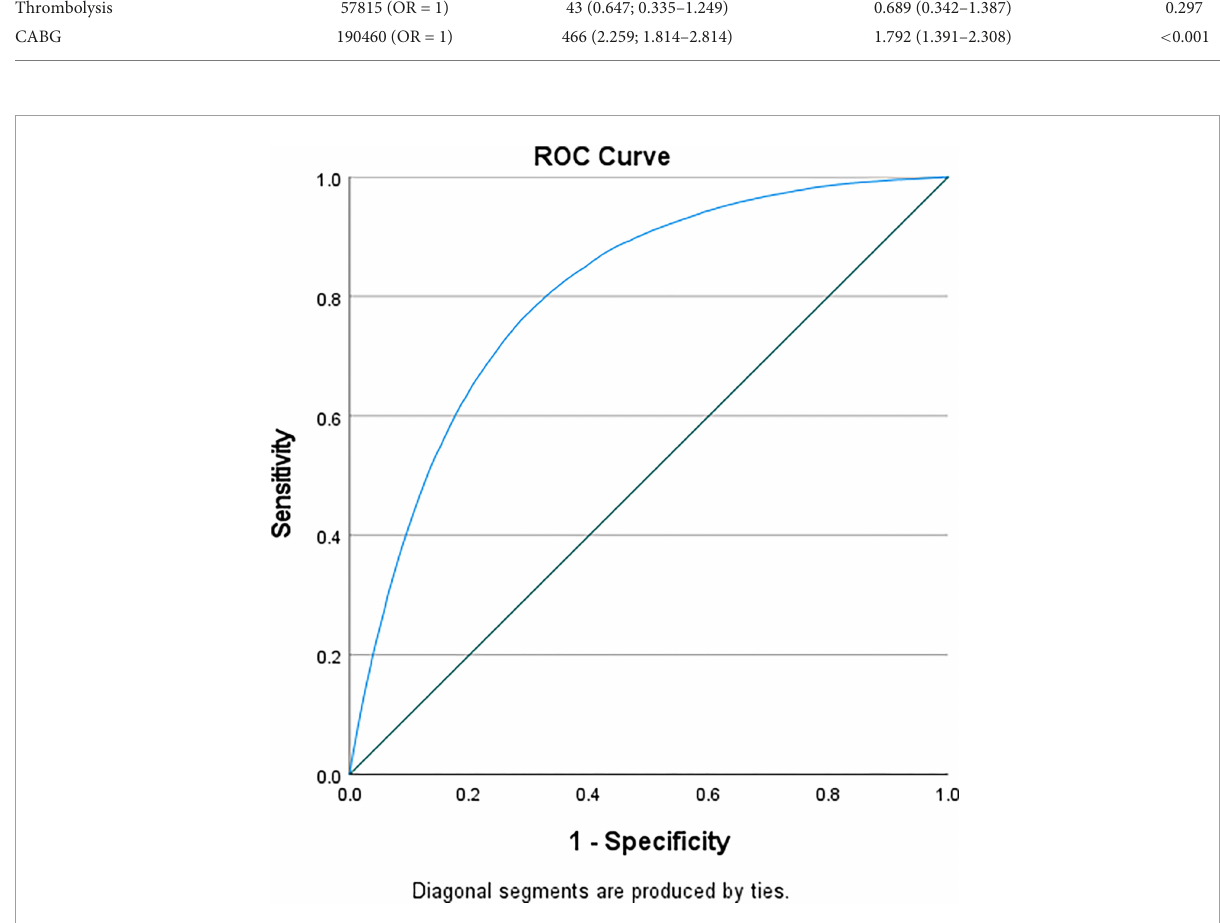
FIGURE3 ROC curve testing the prediction of mortality of the multivariable regression model in patients with STEMI and